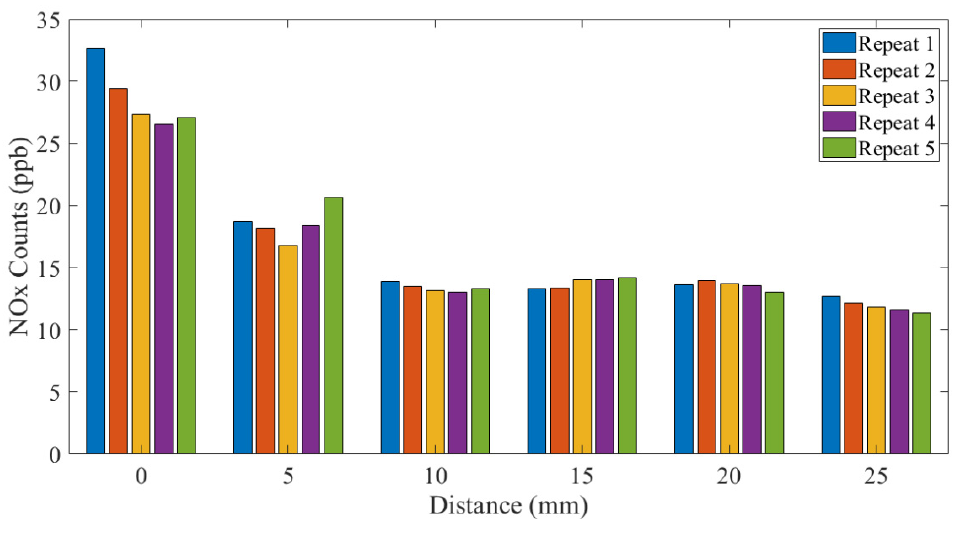
Figure 5. NOx measurements: 55 L/min extraction system.